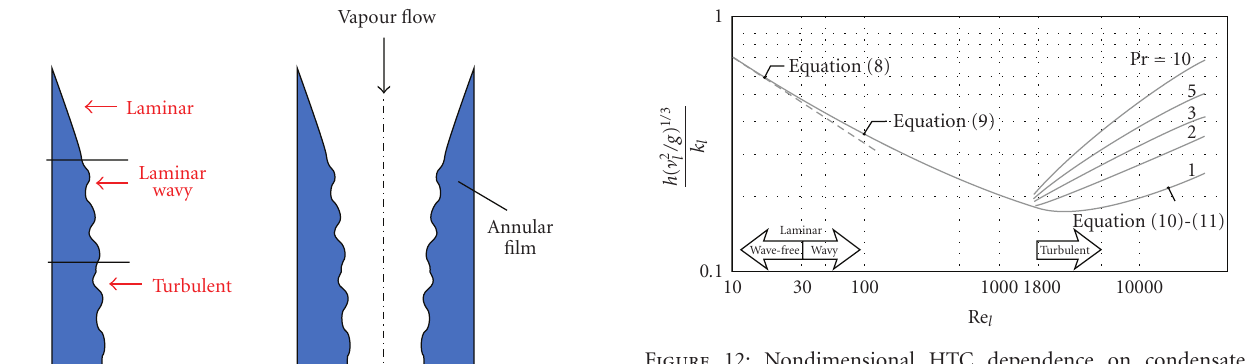
Figure 12: Nondimensional HTC dependence on condensate Reynolds number, for condensation on a vertical plate